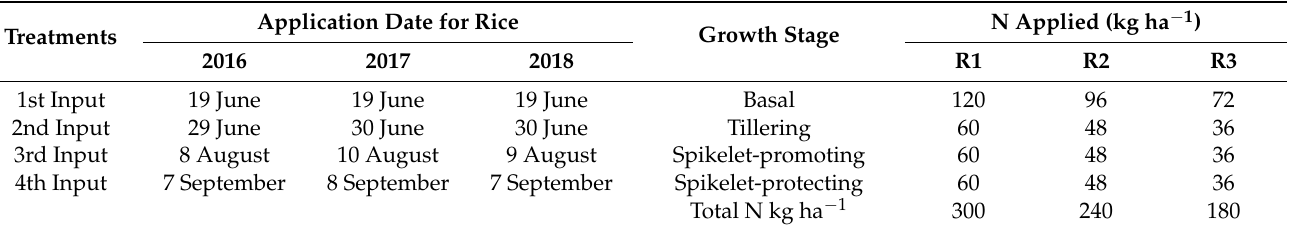
Table 2. Nitrogen application rates for the experimental treatments at various growth stages of rice (kg ha − 1